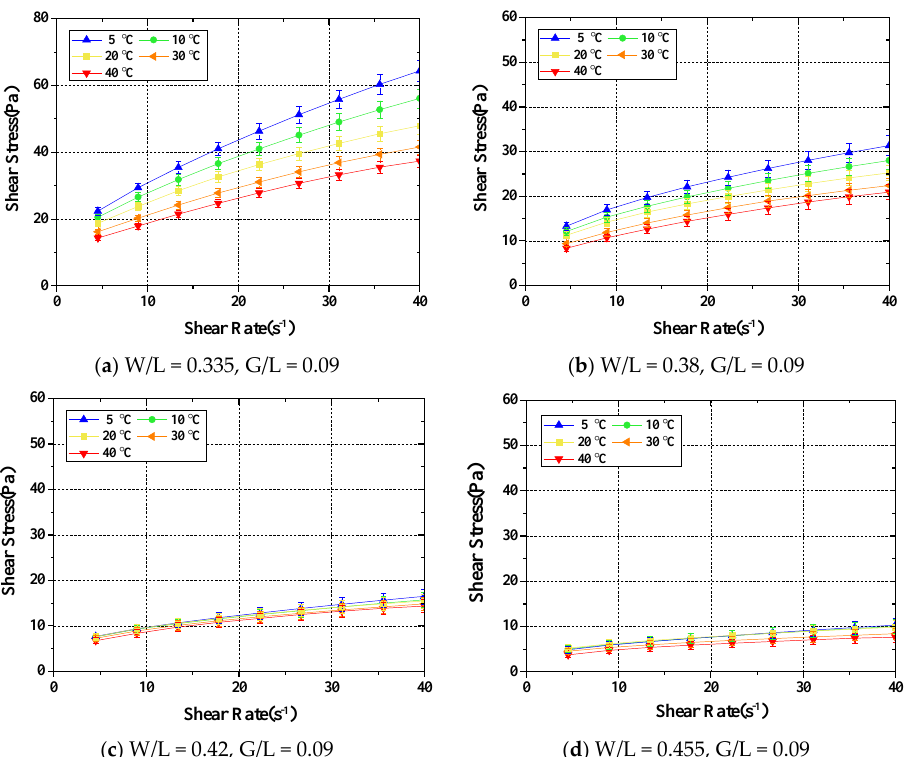
Figure 4. The test results of the rheological properties for standard reference materials by mixing ratios.